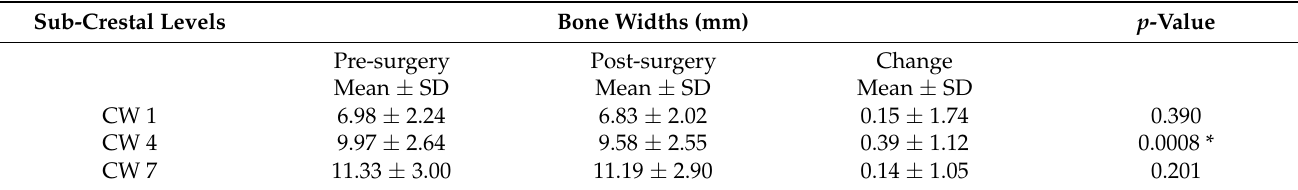
Table 2. The differences in bone widths around implants at three levels were found between before and after the implant surgery.